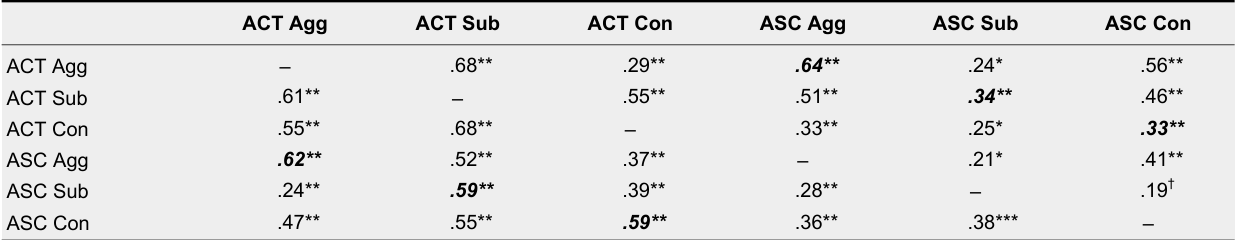
Multitrait-Multimethod Correlation Matrix for ACT Scale and ASC Scale, Sample 3 Students (Lower-Left) and Parents